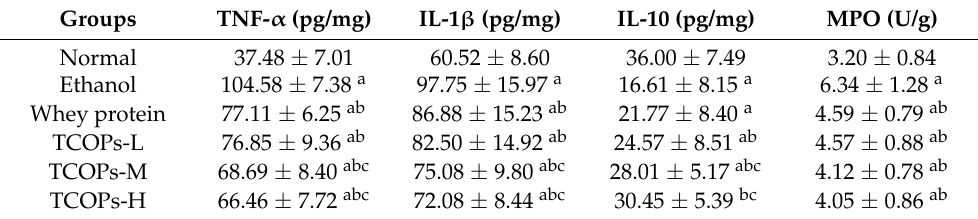
Table 6. Effect of TCOPs on the content of inflammatory factors in gastric tissue of